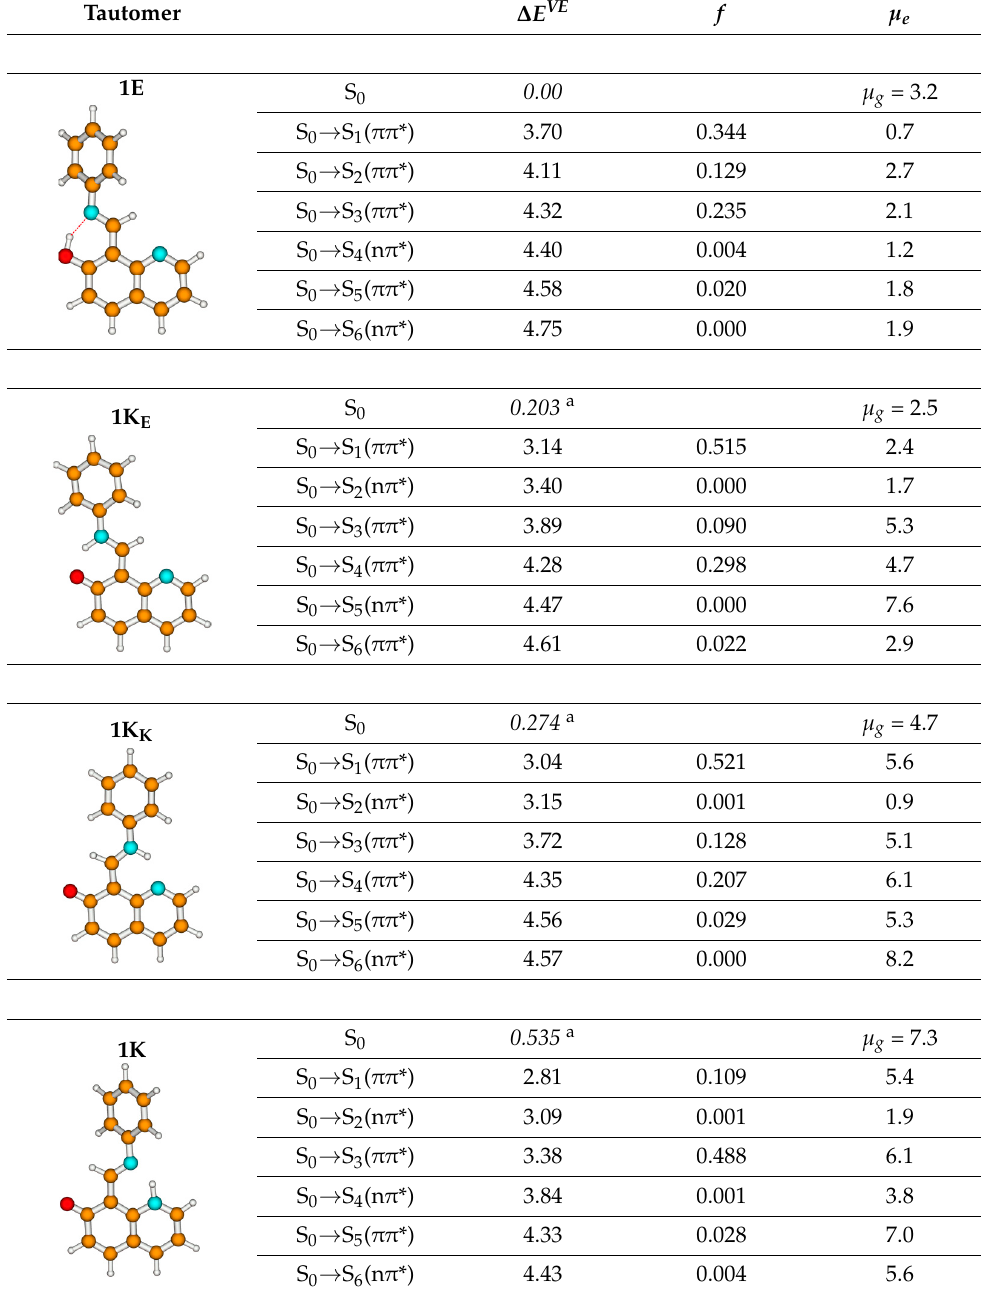
Table 1. Vertical excitation energy, ∆ E VE (in eV), oscillator strength, f , and dipole moment, µ e ( in Table 1. Vertical excitation energy, Δ E VE (in eV), oscillator strength, f , and dipole moment, μ e ( in Debye), of the lowest excited singlet states calculated with the CC2/aug-cc-pVDZ method for the Debye), of the lowest excited singlet states calculated with the CC2/aug-cc-pVDZ method for the Table 1. Vertical excitation energy, Δ E VE (in eV), oscillator strength, f , and dipole moment, μ e ( in ground state equilibrium forms of 1 , optimized at the MP2/cc-pVDZ theory level. The dipole moment ground state equilibrium forms of 1 , optimized at the MP2/cc-pVDZ theory level. The dipole mo- Table 1. Vertical excitation energy, Δ E VE (in eV), oscillator strength, f , and dipole moment, μ e ( in Debye), of the lowest excited singlet states calculated with the CC2/aug-cc-pVDZ method for the of the ground-state, µ g (in Debye, MP2/cc-pVDZ). ment of the ground-state, μ g (in Debye, MP2/cc-pVDZ). Debye), of the lowest excited singlet states calculated with the CC2/aug-cc-pVDZ method for the ground state equilibrium forms of 1 , optimized at the MP2/cc-pVDZ theory level. The dipole mo- Table 1. Vertical excitation energy, Δ E VE (in eV), oscillator strength, f , and dipole moment, μ e ( in ground state equilibrium forms of 1 , optimized at the MP2/cc-pVDZ theory level. The dipole mo- ment of the ground-state, μ g (in Debye, MP2/cc-pVDZ). Debye), of the lowest excited singlet states calculated with the CC2/aug-cc-pVDZ method for the Tautomer ment of the ground-state, μ g (in Debye, MP2/cc-pVDZ). ground state equilibrium forms of 1 , optimized at the MP2/cc-pVDZ theory level. The dipole mo- ment of the ground-state, μ g (in Debye,